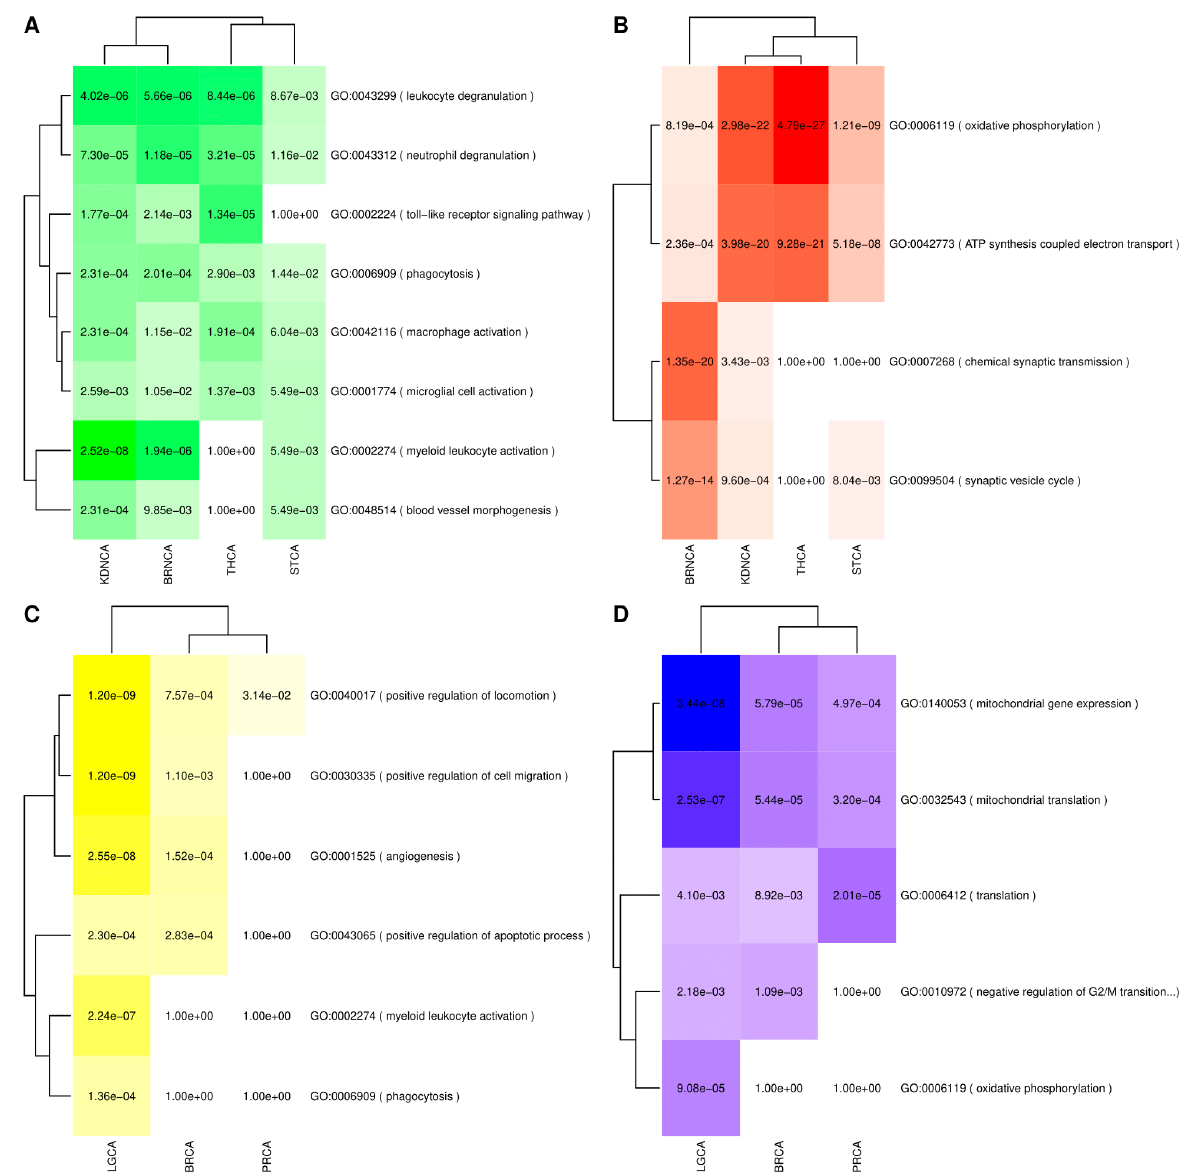
Figure 4. GO overrepresentation analysis results of genes significantly deregulated in PD and cancers. ( A ) Genes upregulated in PD and its SDDCs. ( B ) Genes downregulated in PD and its SDDCs. ( C ) Genes upregulated in PD and downregulated in its ODDCs. ( D ) Genes downregulated in PD and upregulated in its ODDCs. Color hues are proportional to the FDR adjusted p-vales of the overrepresentation results, with darker hues corresponding to lower p